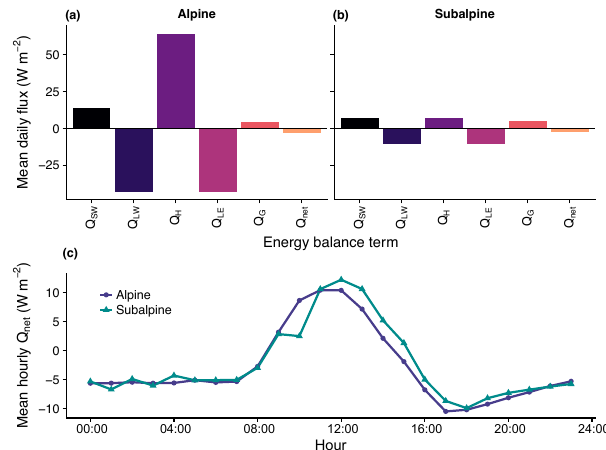
Figure 8. Simulated snowpack energy balance in the alpine (a) and subalpine (b) , plus mean hourly Q net (c) for days of cold content gain without precipitation.